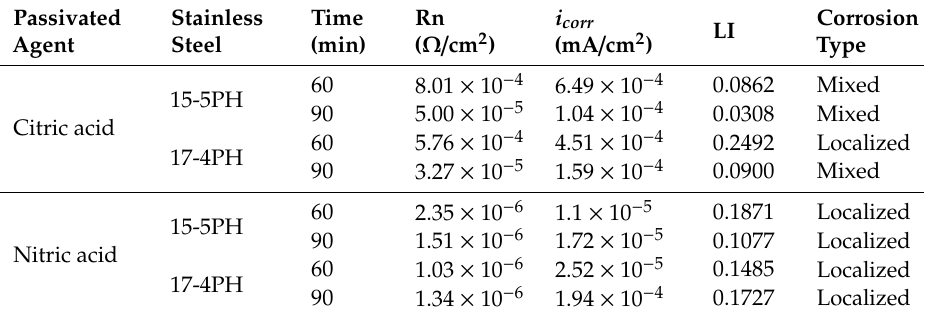
Table 3. Electrochemical noise parameters at various conditions in 5 wt. % NaCl at 49 ◦ C. Passivated